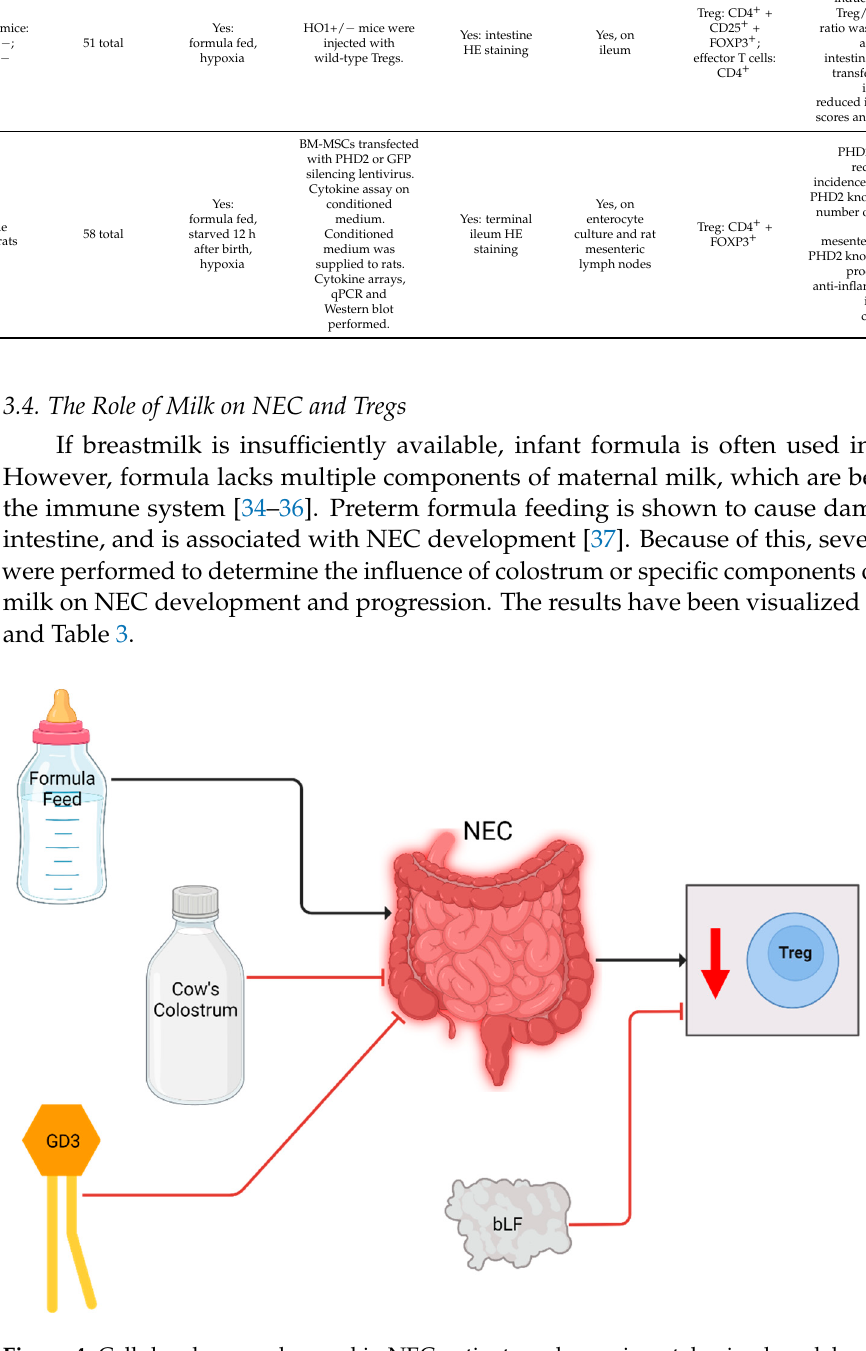
Figure 4. Cellular changes observed in NEC patients and experimental animal models and the effect of breastmilk related interventions. After NEC diagnosis or induction, Treg levels were decreased (downward arrow). Formula increased NEC incidence and decreased Treg levels in piglets, whereas colostrum reduced NEC incidence and normalized Treg levels. GD3 supplementation negated the decrease in Tregs in a rat model. bLF supplementation increased Treg levels of individual NEC patients.